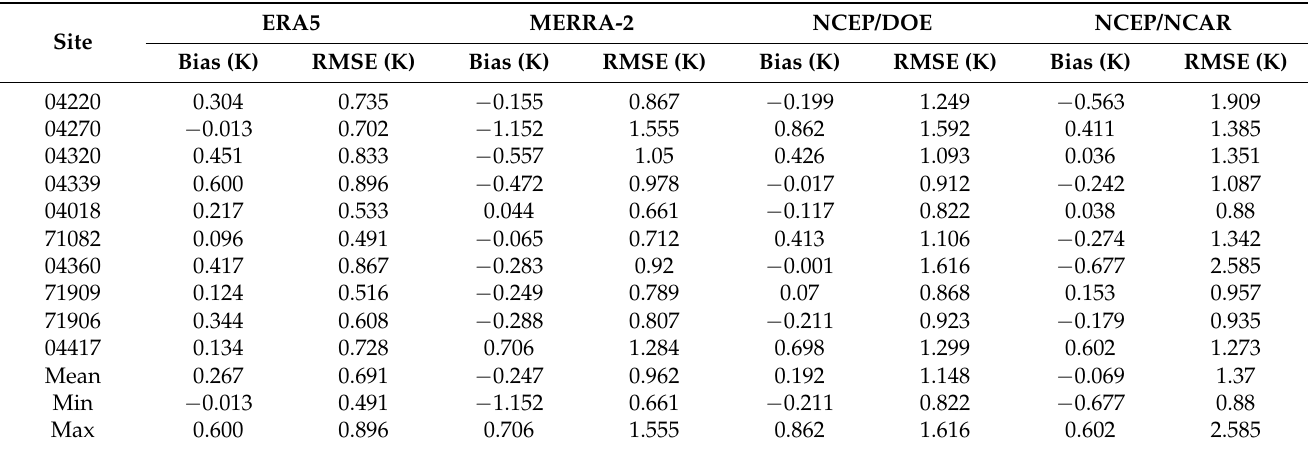
Table 3. The 15-year mean bias and RMSE values for the T m of 10 stations derived from four